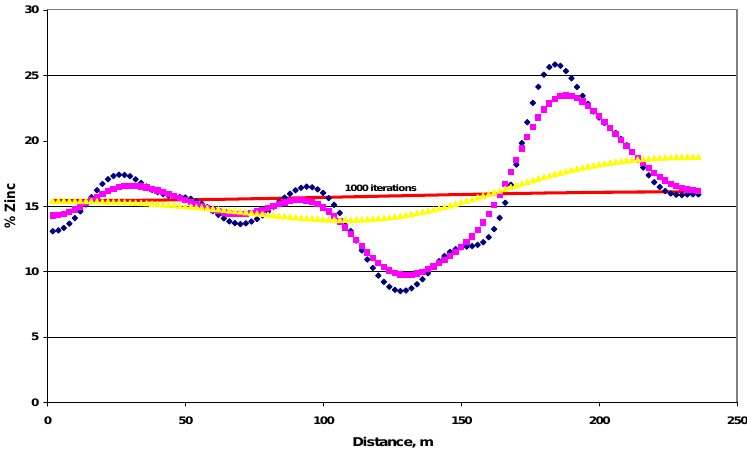
Fig. 19. Same as Fig. 18 but iterative process was constrained to preserve average zinc value of 15.61%. Result after 4 iterations ( k = 5) is same as in Fig. 18 but result after 1000 iterations ( k = 1000) is slightly different. Intermediate steps for k = 10 and 100 are also